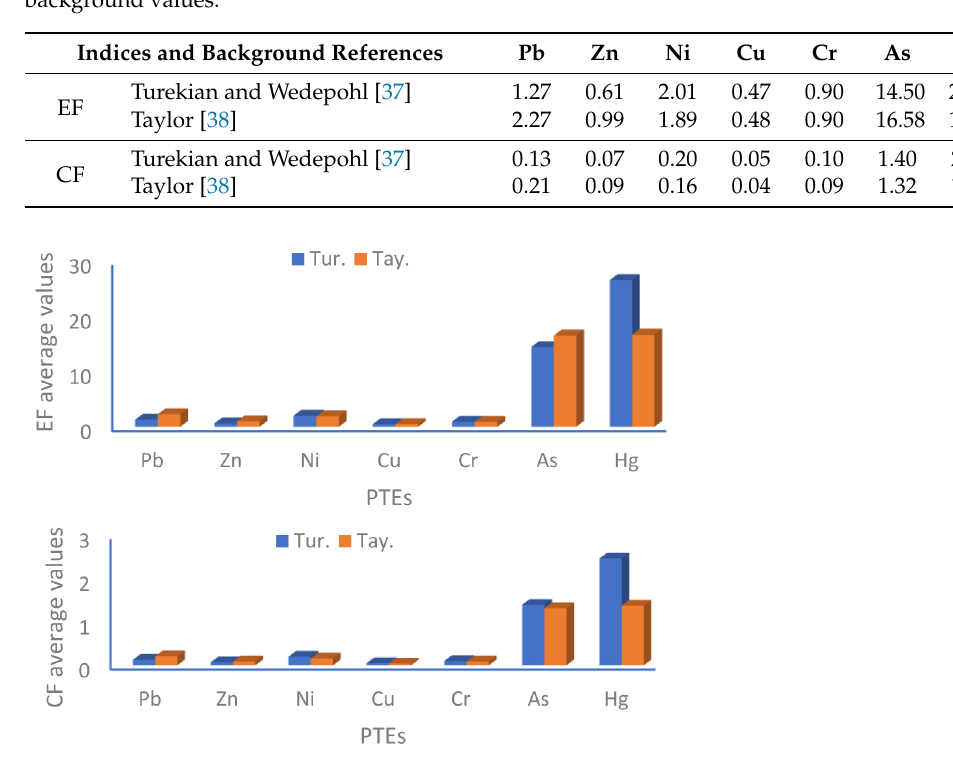
Table 3. The average values of enrichment factor (EF) and contamination factor (CF), based on background values.